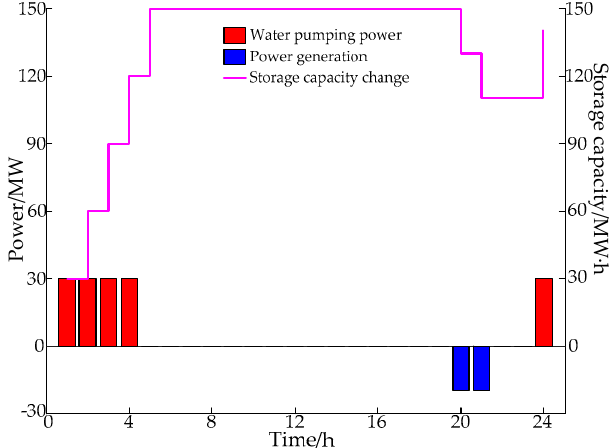
Figure 13. Changes of pumping and generating power and storage capacity of the PSPS.